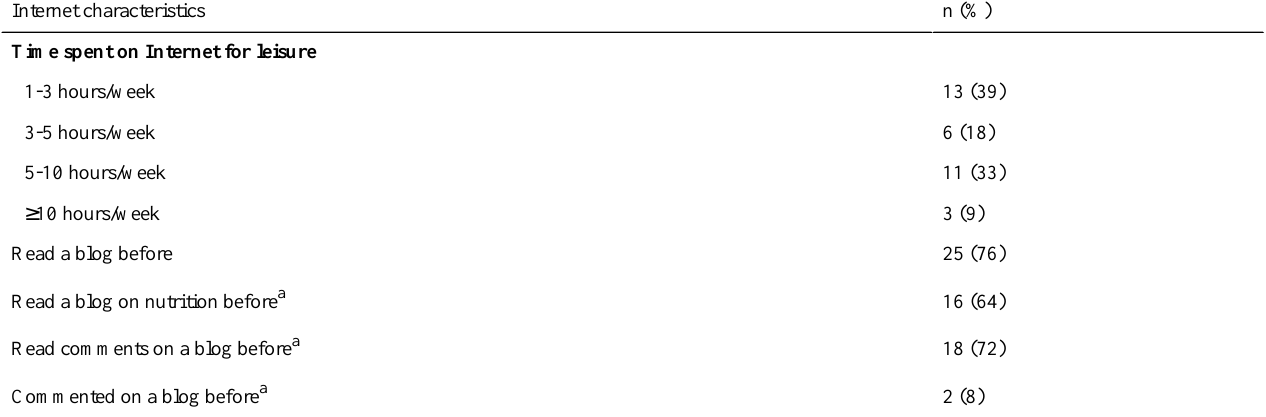
Table 2. Internet use characteristics of the 33